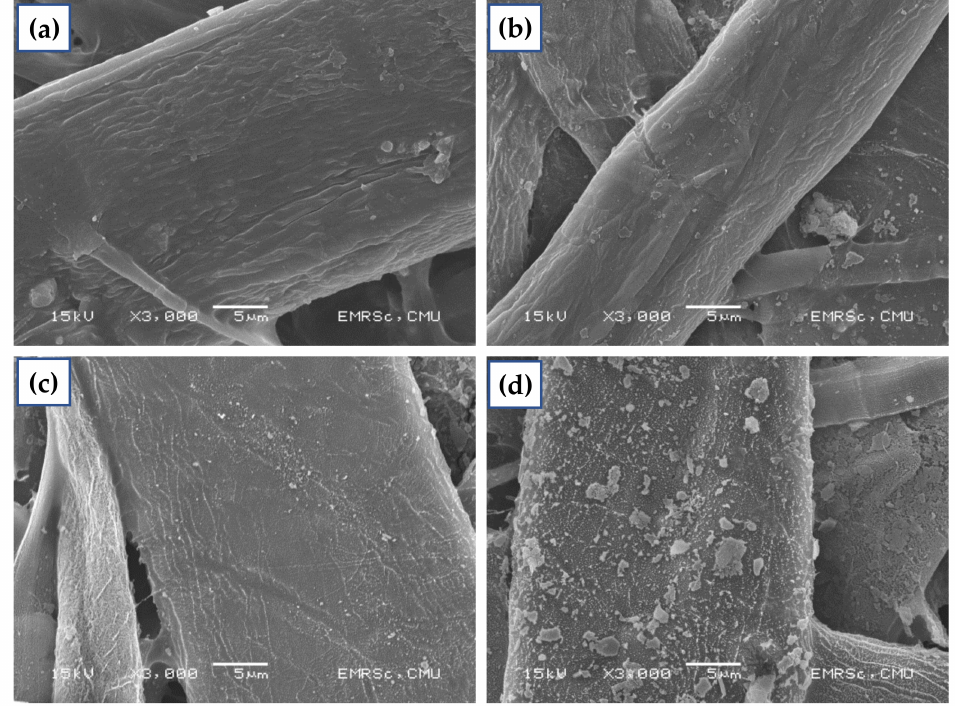
Figure 10. SEM images of ( a ) untreated, ( b ) 3 min, ( c ) 5 min, and ( d ) 7 min at 200 mTorr 50 Watts (3000 ×